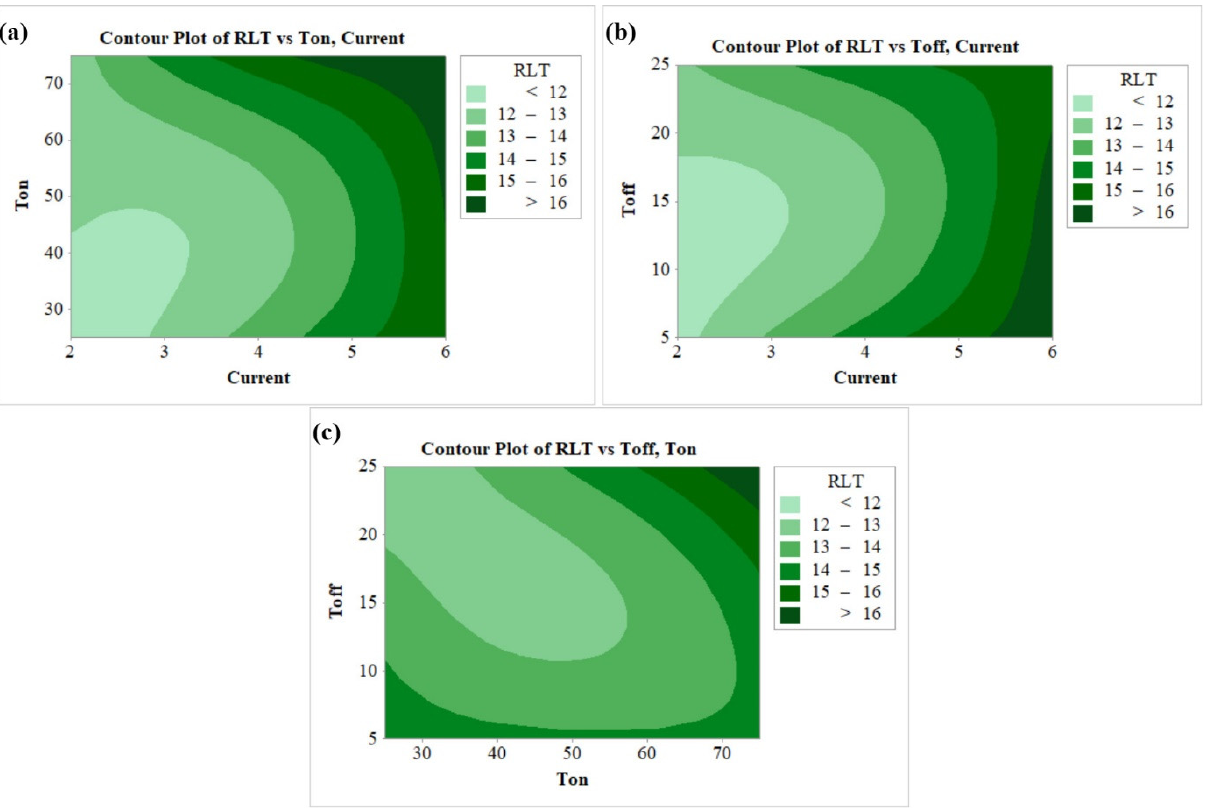
Figure 7. Contour plots for ( a ) RLT vs T on , current, ( b ) RLT vs T off , current, ( c ) RLT vs T off , T